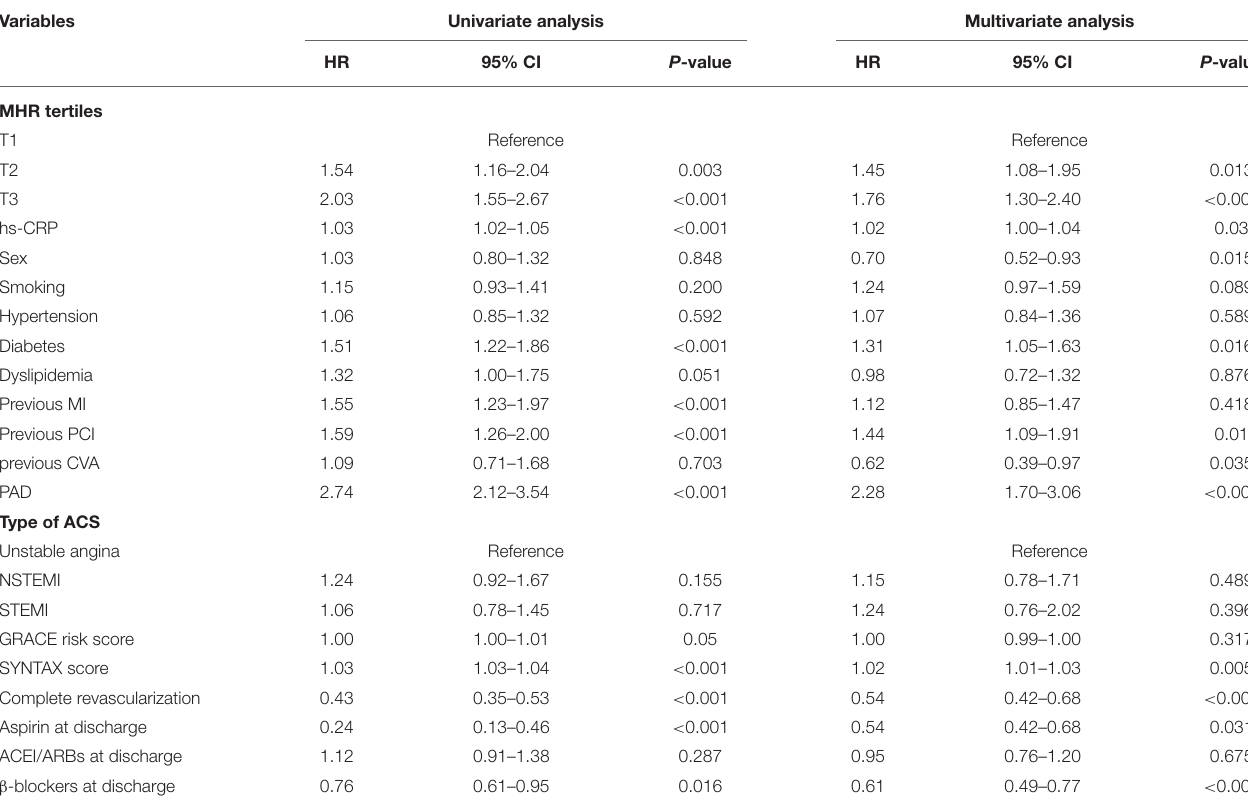
TABLE 3 | Univariate and multivarite cox proportional hazards analyses for the primary endpoint according to the MHR tertiles.